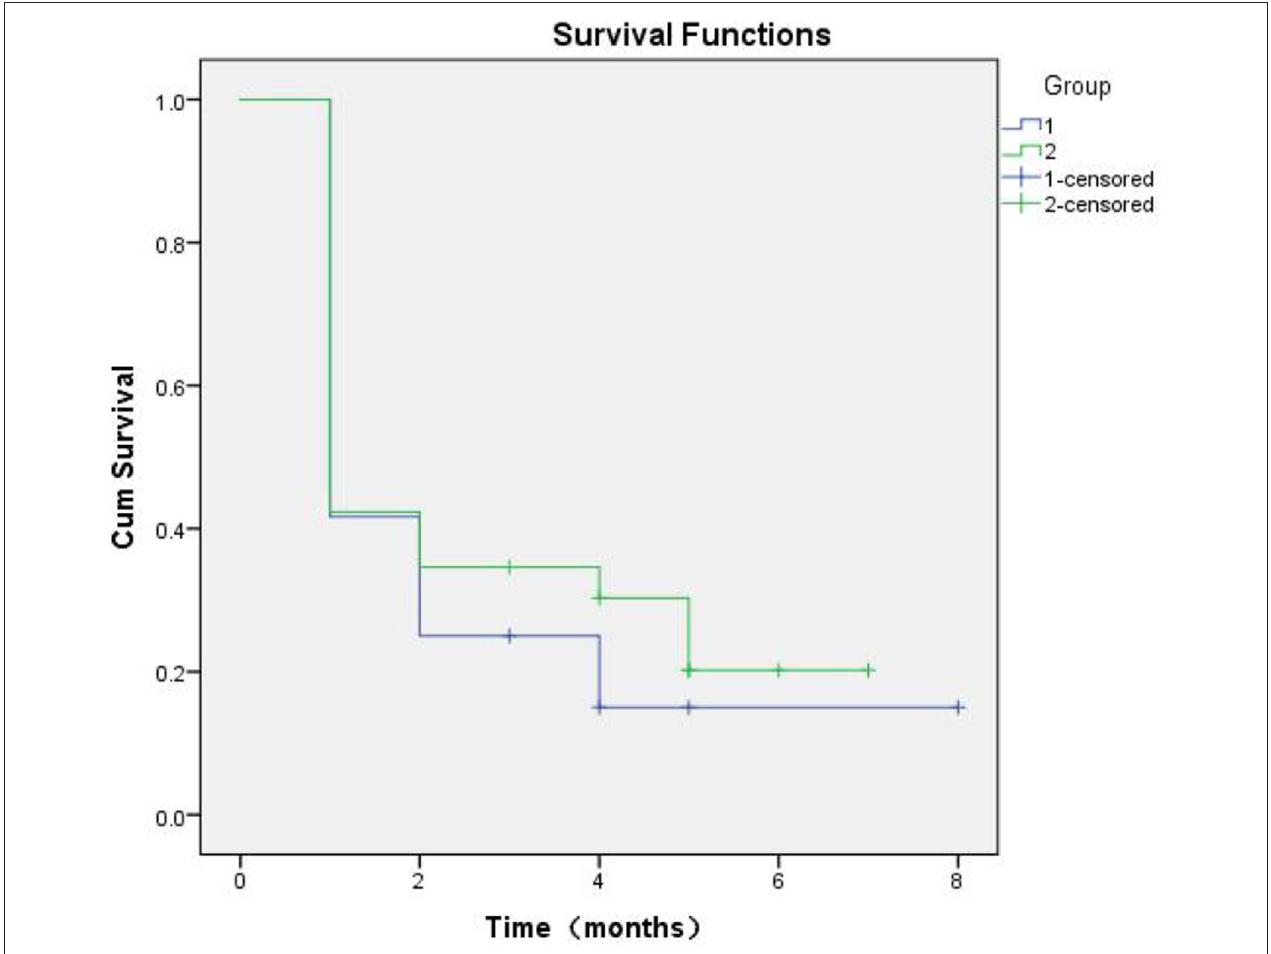
FIGURE 6 | Kaplan-Meier curves based on SERPINA3 levels in patients with alcohol dependence during follow-up of up to 8 months ( P = 0.489).